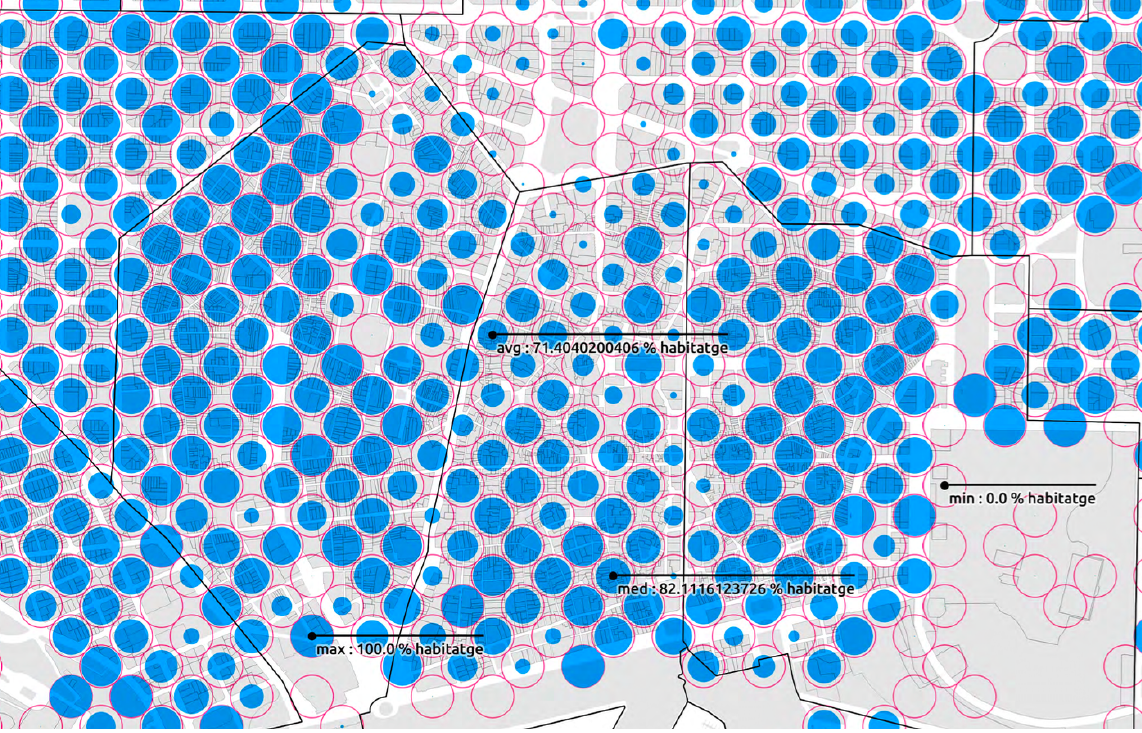
Figure 11. Proportion of housing areas (blue) in relation to other uses (pink) in CVD. Source: Trescientosmil kms